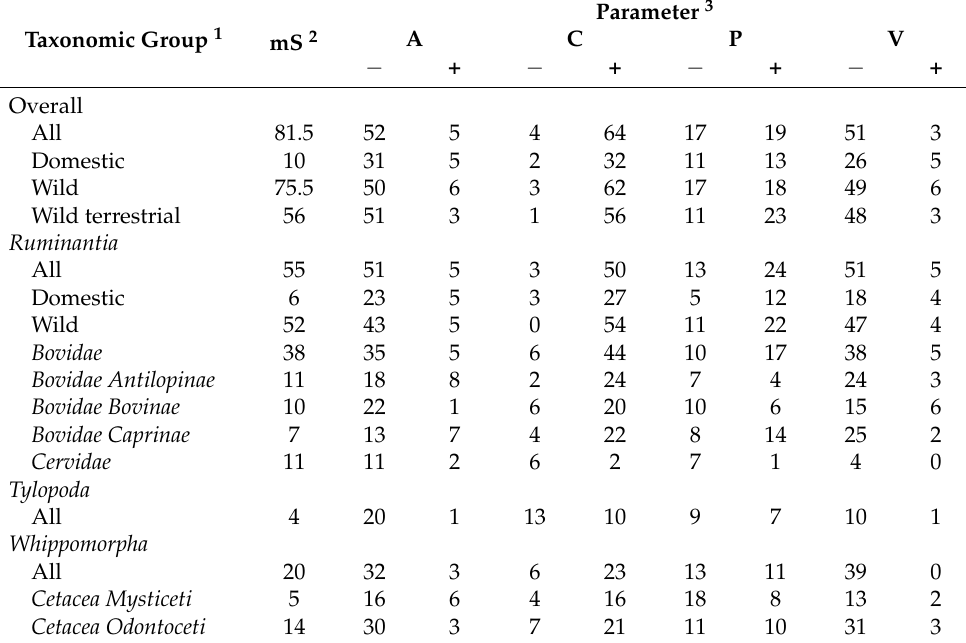
Table 2. Number of neuropeptide prohormone genes by parameter specification in the evolutionary